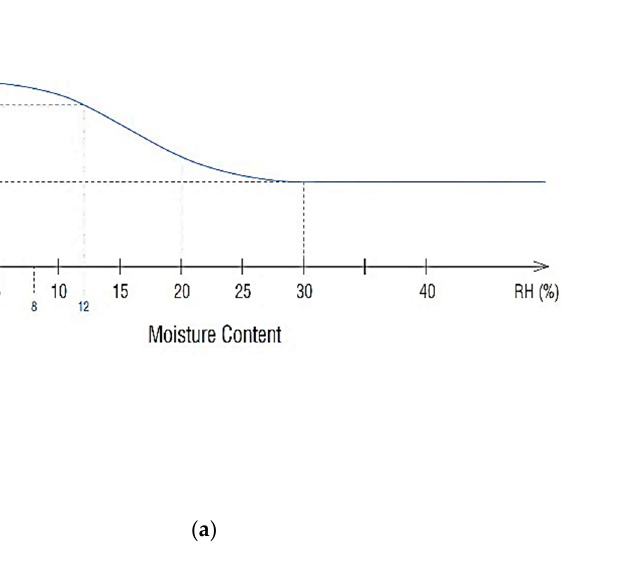
Figure 10. ( a ) Relationship between moisture content and mechanical properties of the timber [24]; ( b ) relationship between RH and electrical resistance [22].